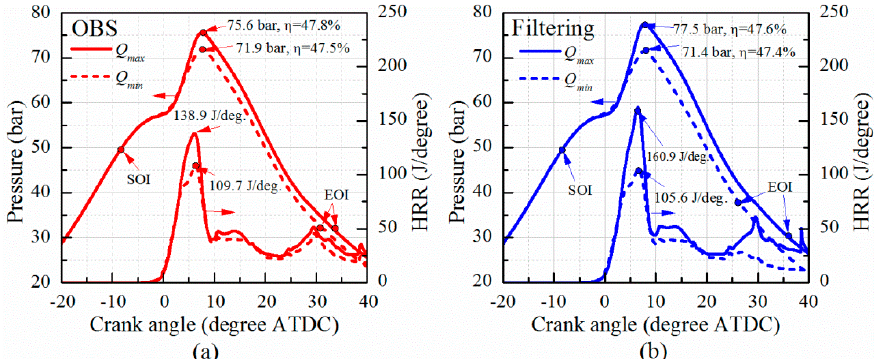
Figure 11. Comparison of the predicted cylinder pressure (on the left Y axis) and heat release rate (HRR, on the right Y axis) between Q max and Q min in 200 cycles for ( a ) the OBS method and ( b ) the filtering method. p t = 150 MPa, Q t = 44.05 mg. SOI denotes the start of injection while EOI denotes the end of the injection. η is the indicating thermal